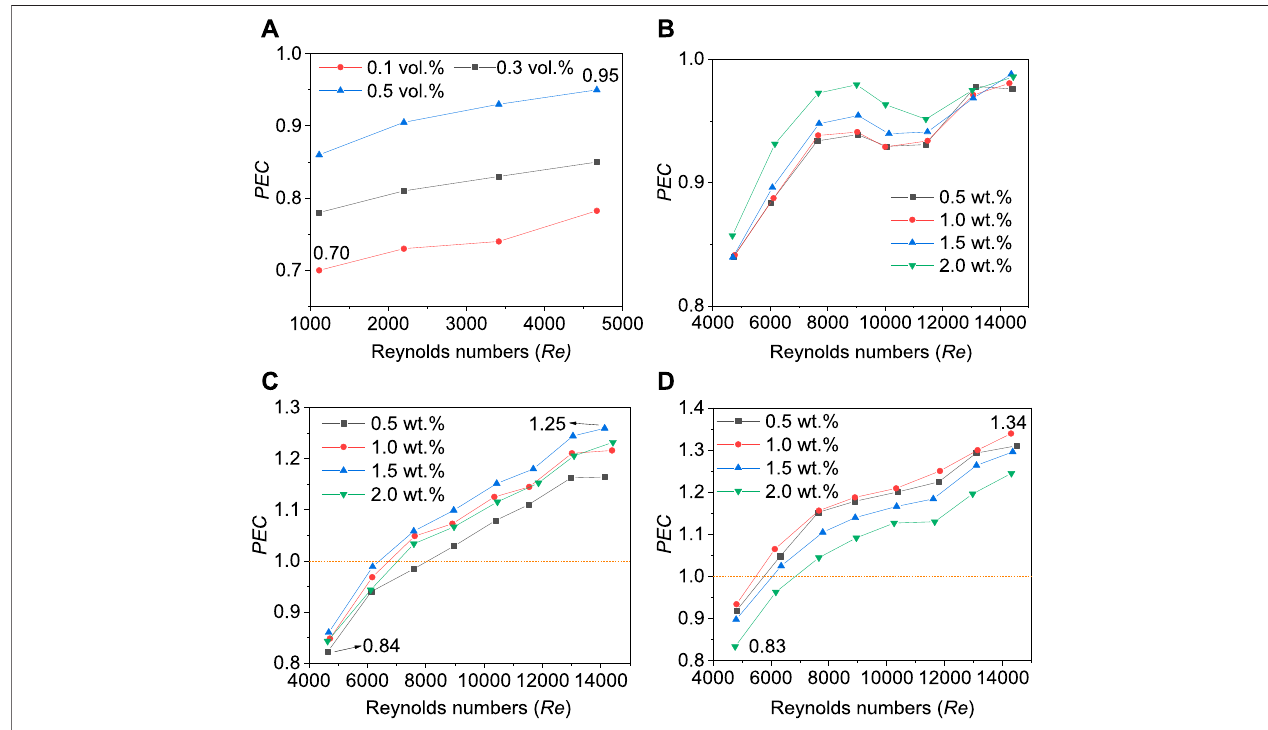
FIGURE 8 | Variations of performance evaluation criteria of water-based nano fl uids with various Reynolds numbers. (A) TiO 2 nano fl uids [71]. (B) Al 2 O 3 nano fl uids [29]. (C) ZnO nano fl uids [29]. (D) CuO nano fl uids [29].